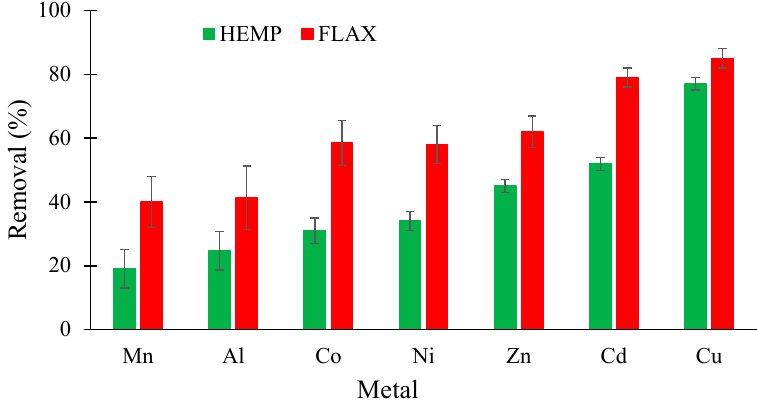
Figure 2. Comparison between removal (in %) of the seven metals by hemp and flax felts from single solutions using an initial metal concentration of 25 mg/L (other conditions: 1 g of felt in 100 mL of solution; contact time, 60 min; agitation speed, 250 rpm; temperature, 22 ± 1°C; n = 5).